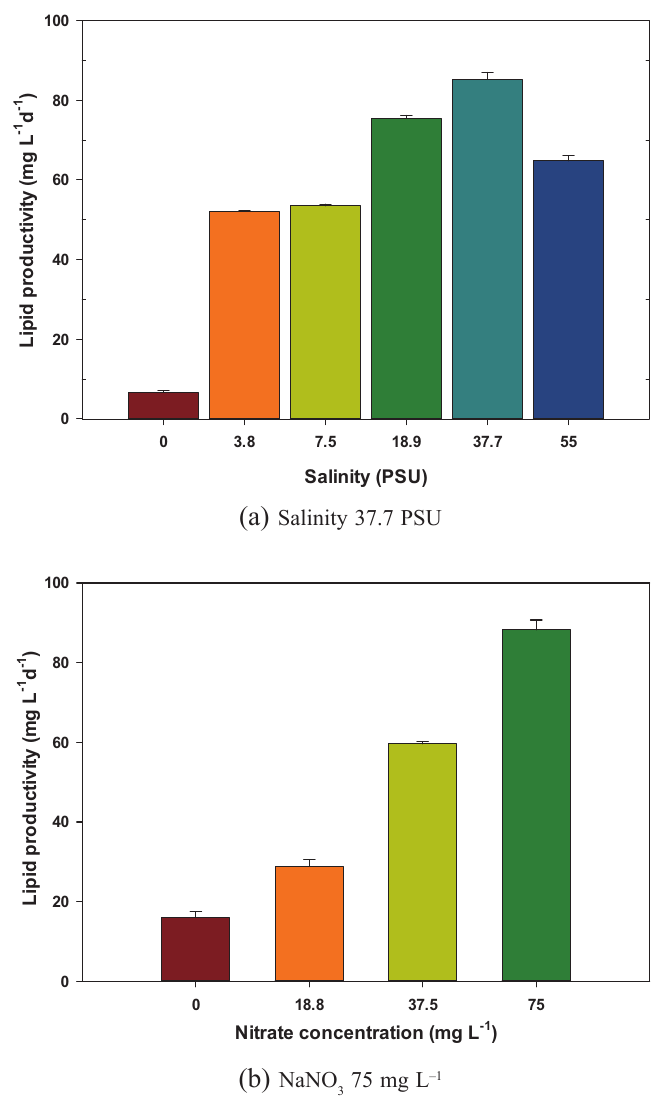
Fig. 5 – Comparison of lipid productivity depending upon different nitrate concentrations and salinity condi-